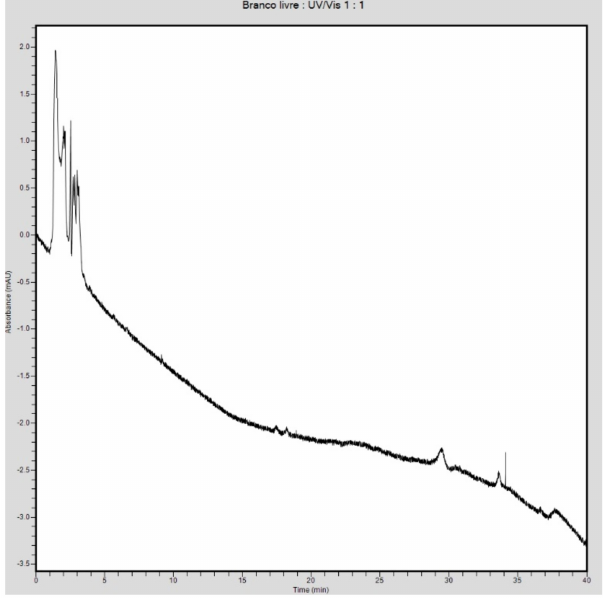
Figure 4. Chromatographic profile of empty